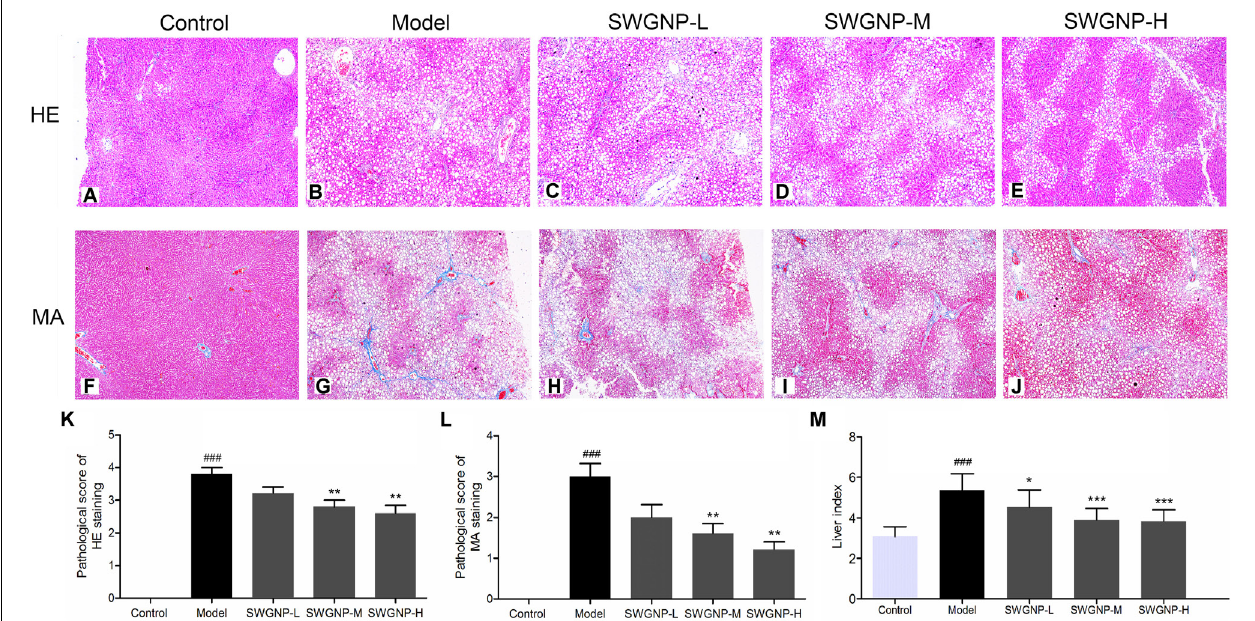
FIGURE 1 | HE staining (A–E) , Masson staining (F–J) , and semi-quantitative analysis (K–M) of liver tissues. With HE staining (200x), the nuclear was shown blue and cytoplasm was red. With Masson staining (200x), the collagen fiber was shown blue and hepatic cells were red. Liver of control rats exhibiting no obvious pathological changes. Livers of CCl 4 dosed rats showing severe fat vacuoles, significant hepatic cell necrosis, and excessive collagen deposition. SWGNP could decrease the pathological scores and liver indexes in a dose dependent manner. Livers after low dose of SWGNP administration showing severe fat vacuoles and collagen deposition. Livers after medium dose of SWGNP administration showing slight hepatic cell necrosis and less collagen deposition and fat vacuoles. Livers after high dose of SWGNP administration displaying with no obvious collagen deposition without any sign of cell degeneration or necrosis. Values were expressed as mean ± SD ( N = 6). ### p < 0.001 vs. control rats; ∗ p < 0.05, ∗∗ p < 0.01, and ∗∗∗ p < 0.001 vs. model